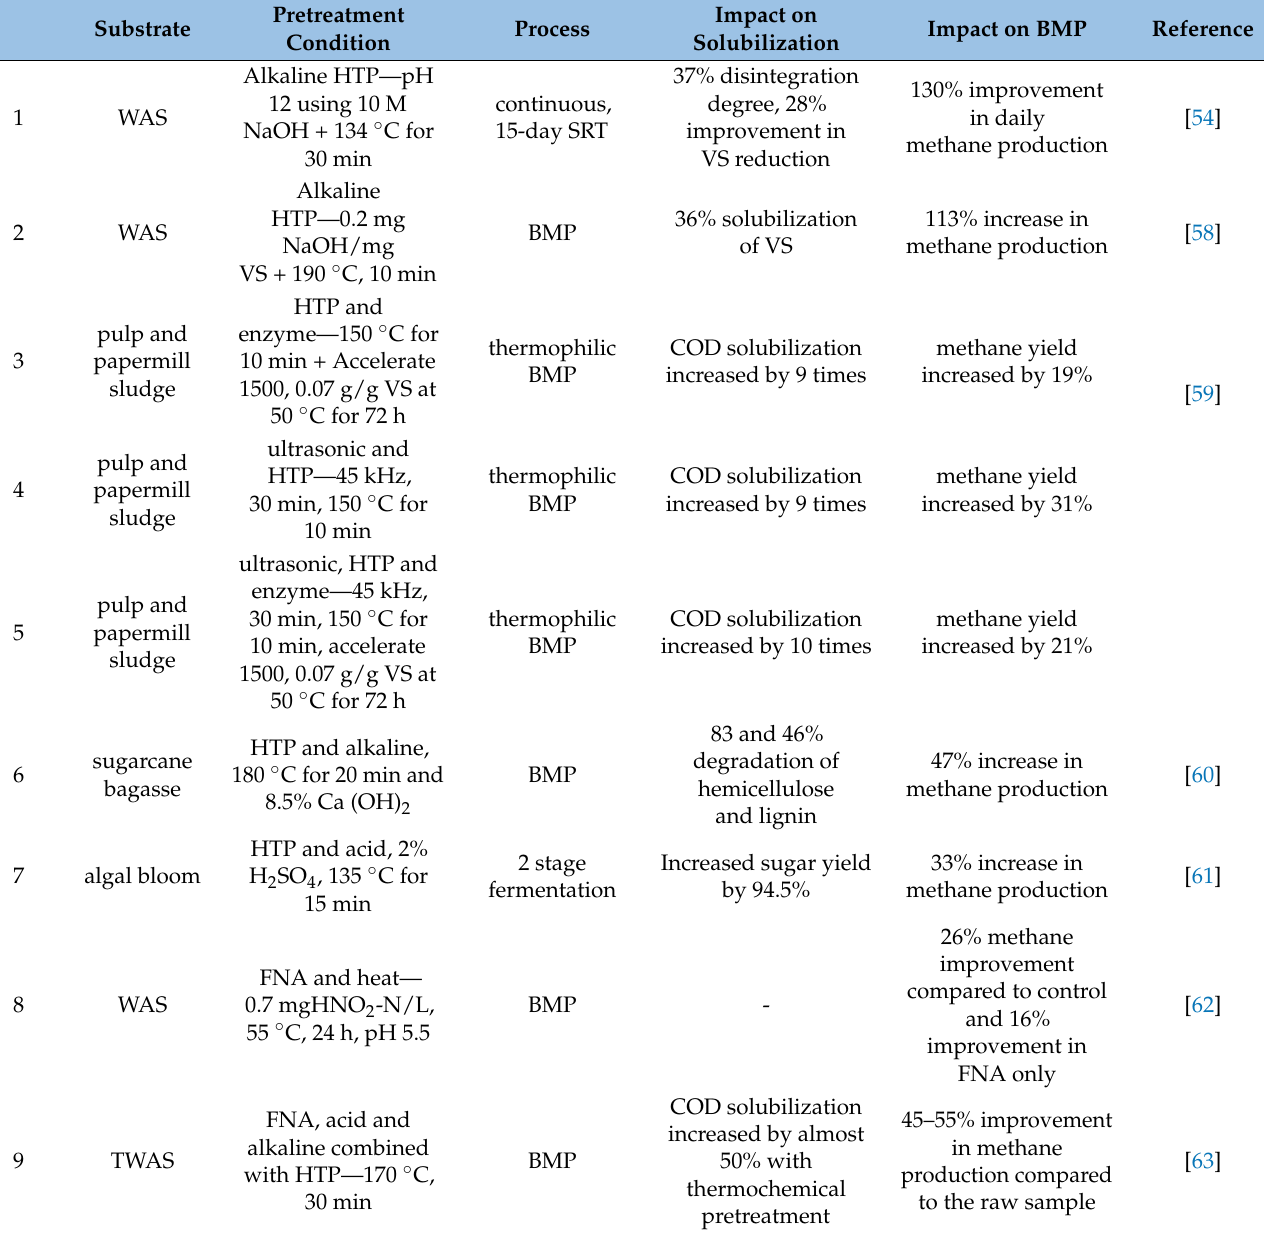
Table 3. Studies on Combined hydrothermal pretreatments prior to